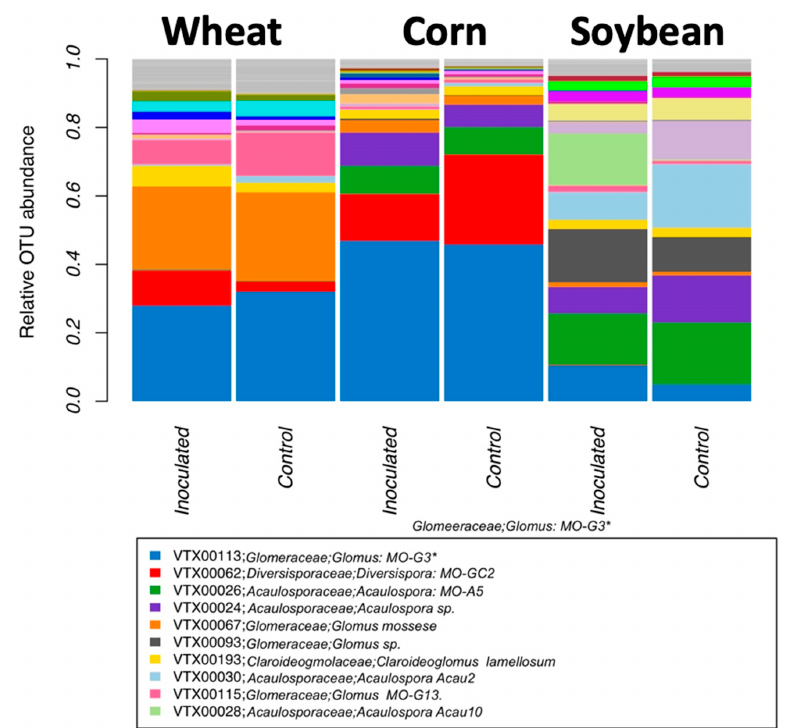
Figure 2. Mean relative abundance of all virtual taxa (VT) and taxonomic affiliation according to the MaarjAM [20] database for the different inoculation treatment and crop species. Microorganisms 2020 , 8 , 83